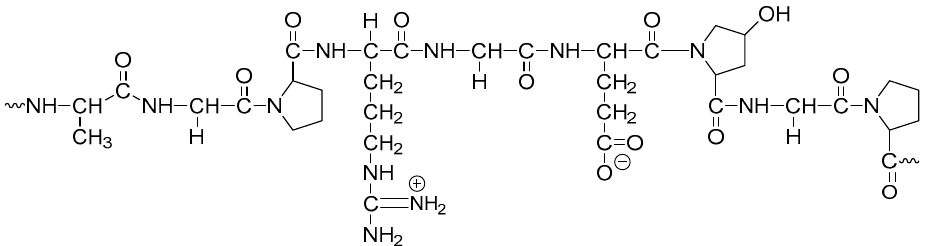
Figure 2. Representative chemical structure of gelatin. Modified from Reference [28] with permis- sion. Wiley-VCH GmbH, 2007.